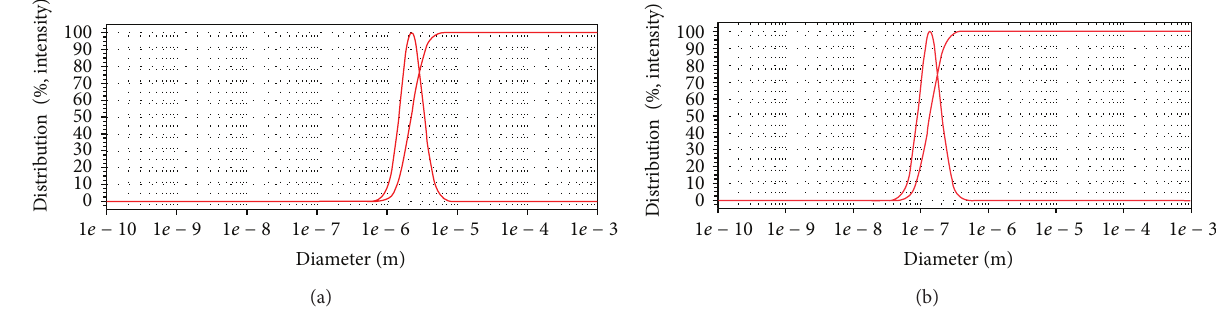
Figure 5: Particle size graphs of methylene blue containing archaeosomes (a) before homogenization and (b) after homogenization (30min). Methylene blue, 16.01.2013 10:28:19